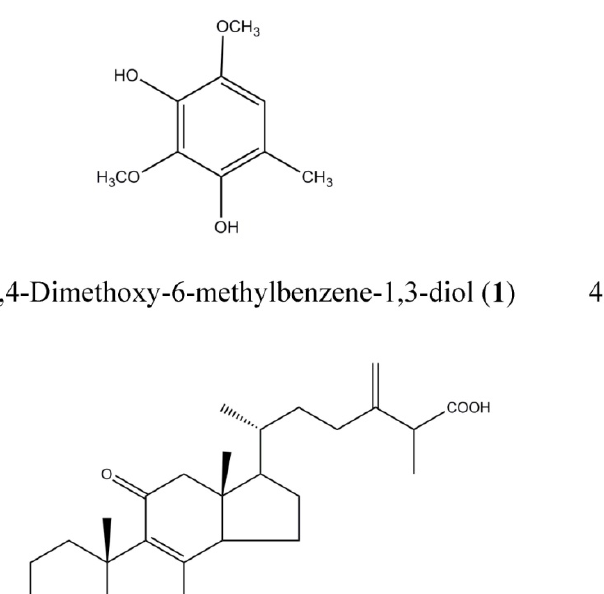
Figure 1. Chemical structures of triterpenoid and benzenoid compounds from solid-cultured mycelia of A. cinnamomea